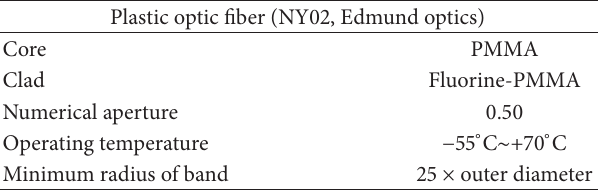
Table 2: Properties of the plastic optic fiber.